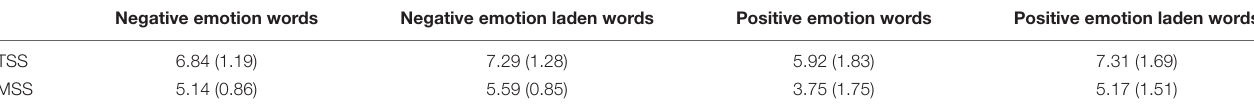
TABLE 2 | Means and standard deviation for total set size (TSS) and mean set size (MSS) for each of the four kinds of emotional words for the whole